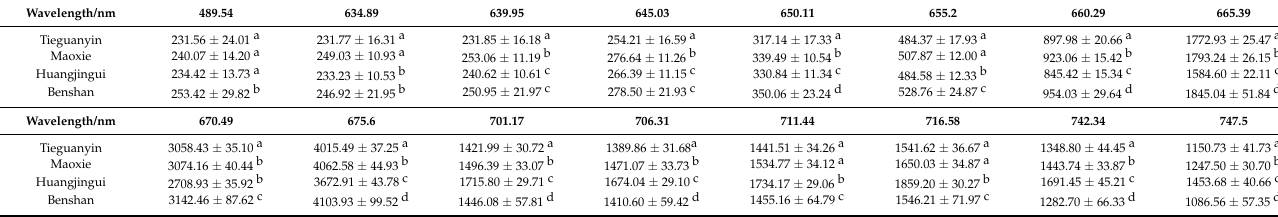
Table 3. ANOVA results for each wavelength.